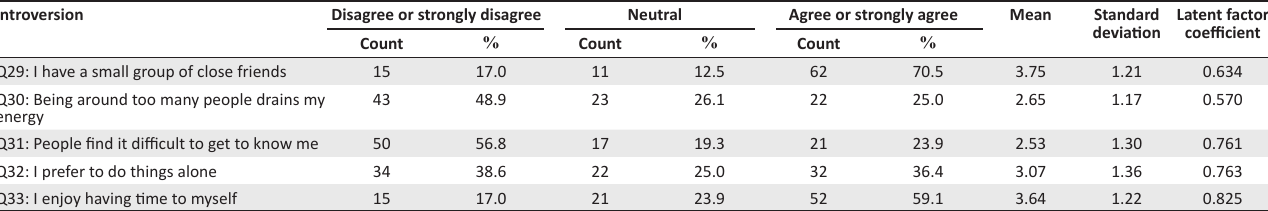
TABLE 6: Descriptive statistics for the construct of introversion.